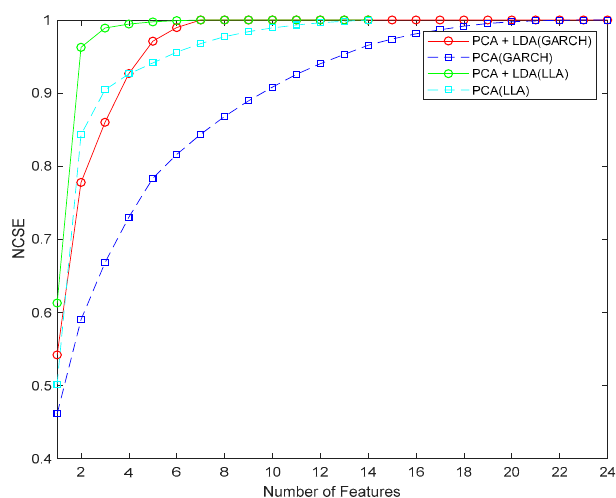
Figure 6. Normalized cumulative summation of eigenvalues of training data for GARCH (1, 1) with and without LL2 (two-classes).